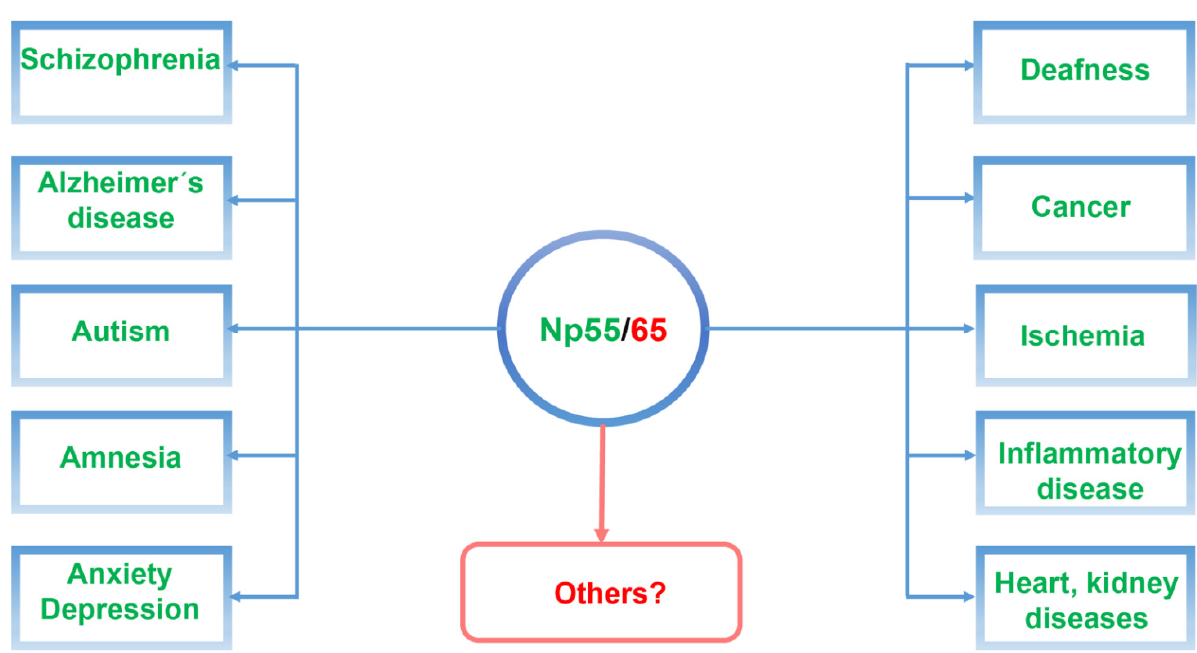
Figure 1. Schematic illustration of neuroplastin Np55/65 as a central component related to neuropsychiatric and neurodegenerative diseases as well as in other diseases associated with neuroplastin malfunctions.